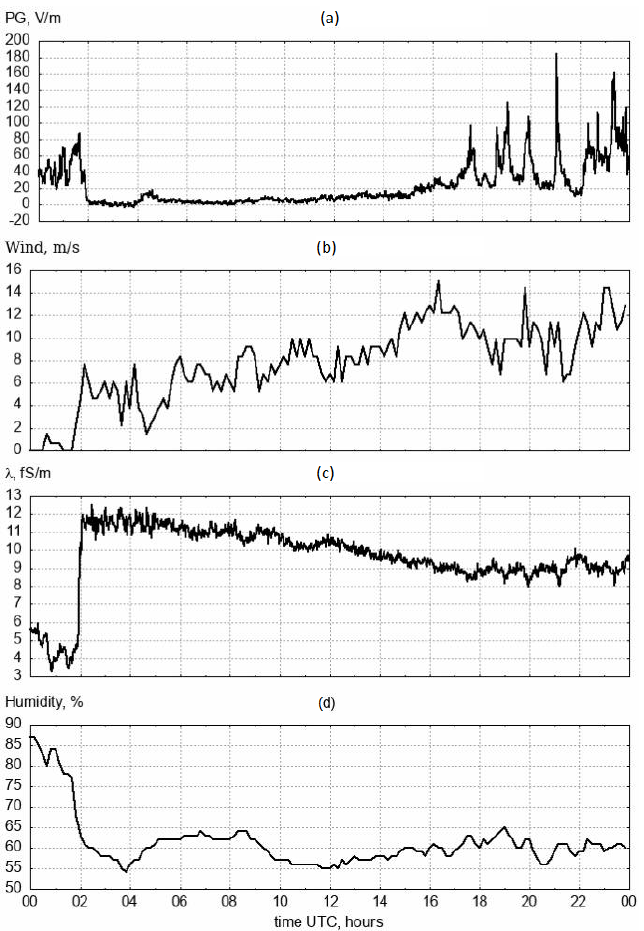
Figure 8. Wind effect for 14 December 2021: ( a ) PG values; ( b ) wind speed; ( c ) air conductivity; ( d ) air